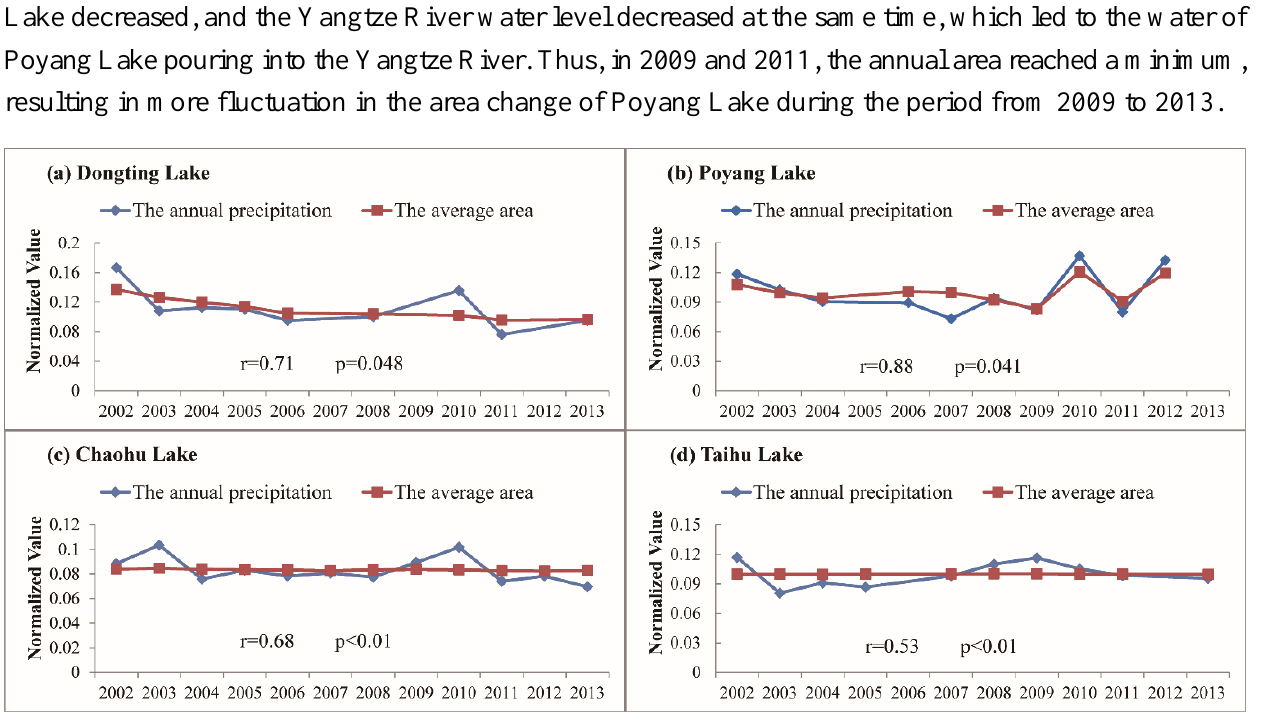
Figure 7. Normalized annual precipitation and average lake area correlation analysis for 2002–2013. ( a ) Dongting Lake; ( b ) Poyang Lake; ( c ) Chaohu Lake; ( d ) Taihu